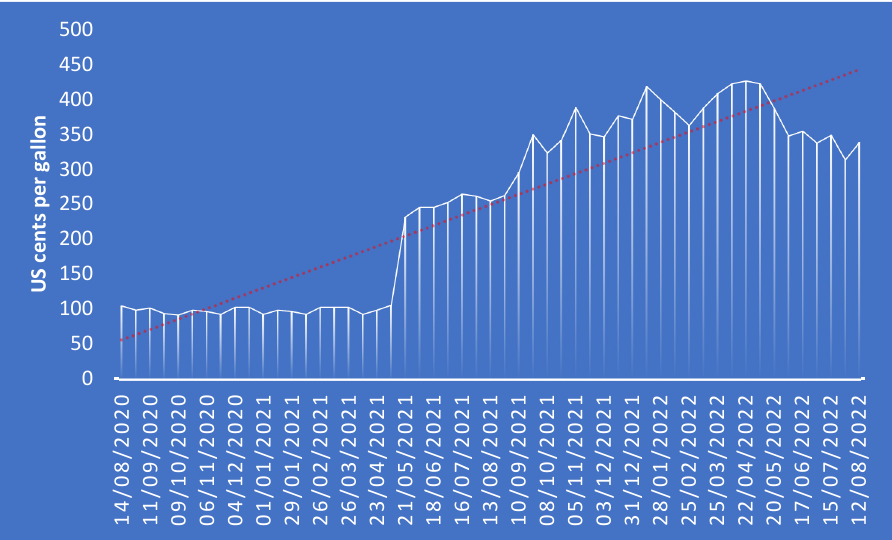
Figure 6. Jet Fuel Price 2020 to August 2022 Source Authors Data from IATA.